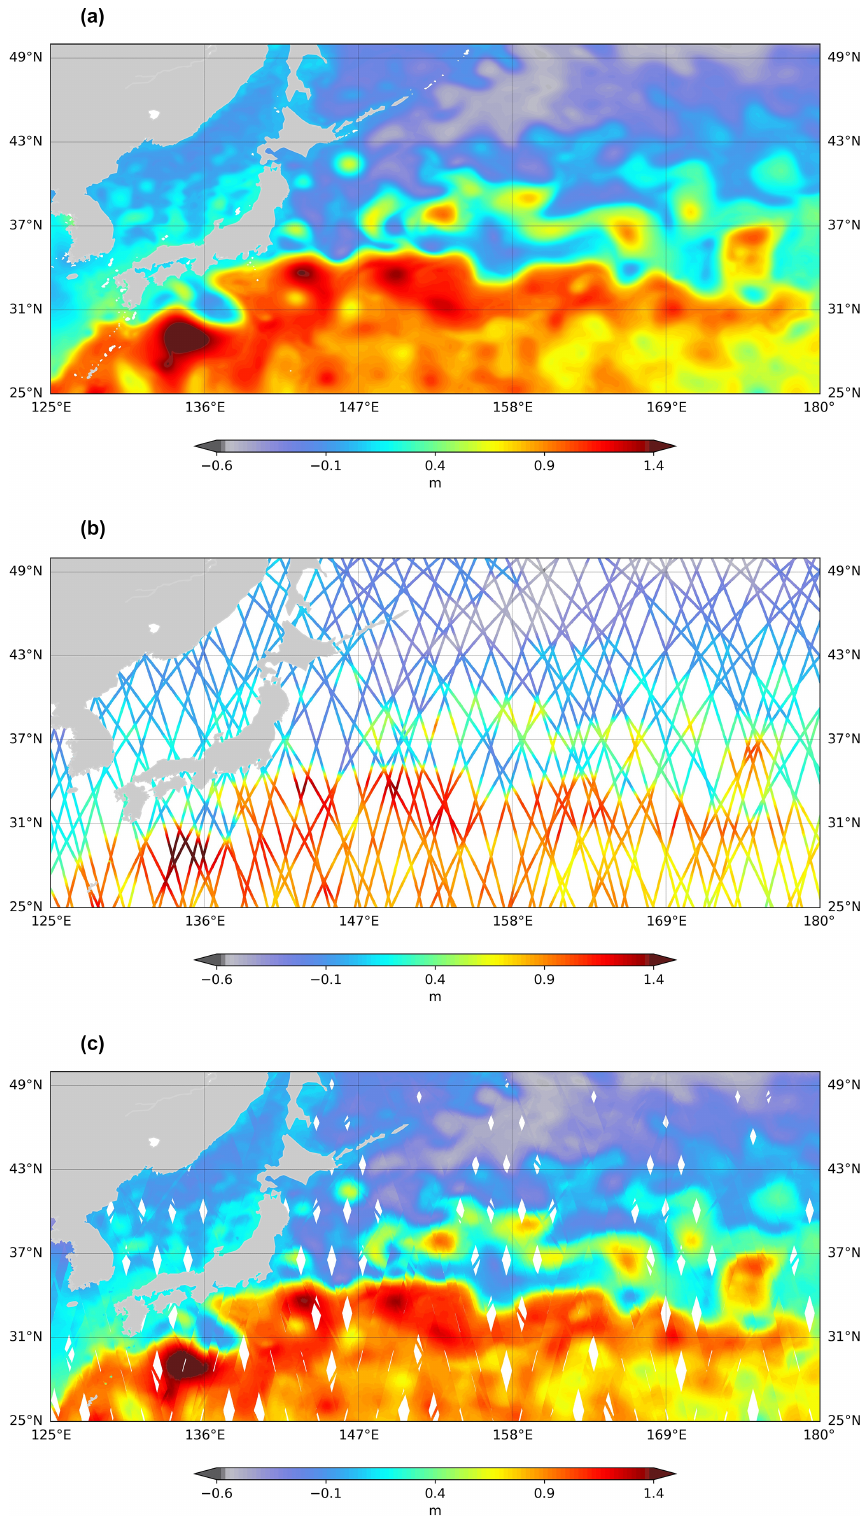
Figure 2. (a) SSH from the truth run (NR) on 4 January 2015; (b) simulated along-track data from Jason3, nadirs of S 1 and S 2 for 7d assimilation cycle; and (c) simulated S 1 + S 2 data (1–8 January